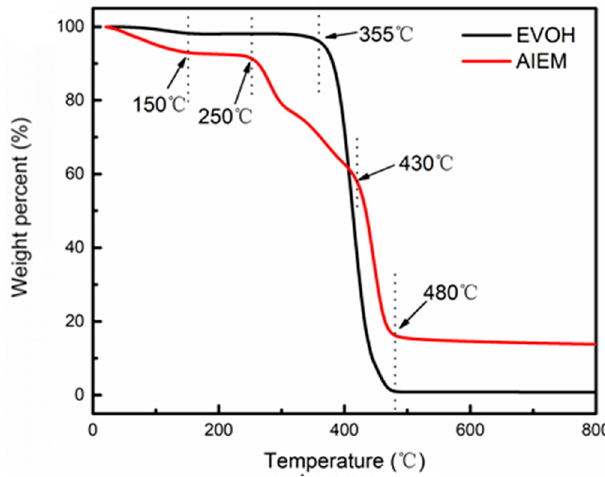
Figure 4. TGA curves of original EVOH and AIEM (GY = 40.9%).